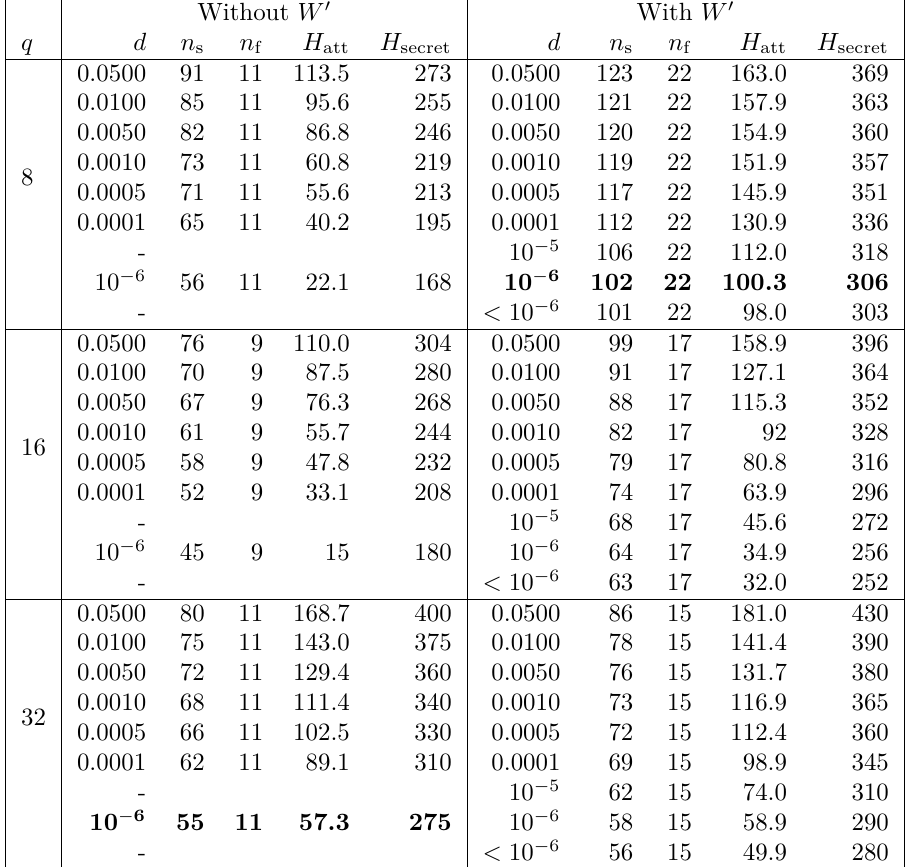
Table 1: The q -ary polar code construction results for 8, 16, and 32 intervals. The codeword consists of 128 symbols. Here, d denotes the per-symbol error probability that indicates the error correction reliability. The number of reliable symbols after error correction is given as n s , of which n f symbols are readable for an attacker. The attacker entropy H att denotes the achievable security level from the remaining secret symbols in an attack scenario. We distinguish between decoding with and without analog helper data W 0